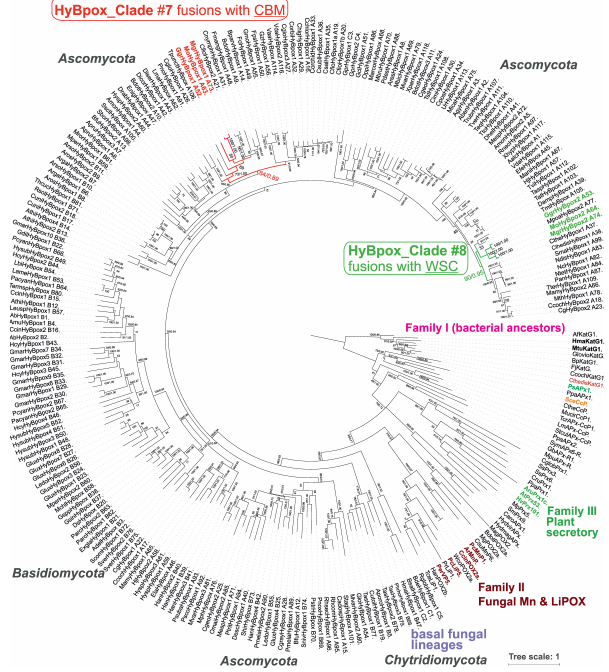
Figure 1. Phylogenetic position of sequences coding for peroxidases from phytopathogenic representatives of the fungal family Magnaporthaceae analysed in an unrooted phylogenetic tree for all known hybrid B peroxidase sequences and selected representatives from all other known clades of the peroxidase-catalase superfamily. Presented is a tree topology obtained with the maximum likelihood method of the MEGA X package [21]. Whelan and Goldman (WAG) as the best substitution model for this dataset of 250 complete protein sequences was used with 5 gamma categories and invariant sites and 100 bootstrap replicates. A very similar tree topology was obtained also with the Mr Bayes approach [22] with a relative burn-in of 25% performed over 1,500,000 generations. Numbers in the nodes represent bootstrap values and posterior probabilities, respectively (presented are only values above 33 / 0.5). All here used abbreviations of peroxidases correspond with RedoxiBase [1] (http: // peroxibase.toulouse.inra.fr /